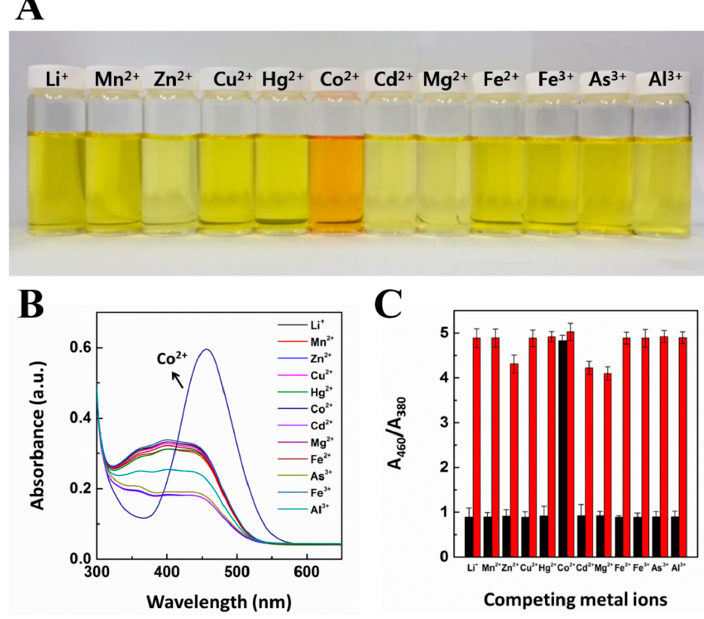
Figure 1. ( A ) Photographs for color changes of CG chemosensor upon addition of various metal ions under visible light; ( B ) UV-vis absorbance spectra of CG chemosensor upon the addition of various metal ions in solution; ( C ) High selectivity toward the cobalt ions and Absorbance responses of CG containing Co 2+ with the other competing metal ions. The concentration of CG chemosensor and cobalt are 7 × 10 − 5 M and 2 ppm, respectively. Each experiment was conducted three times.